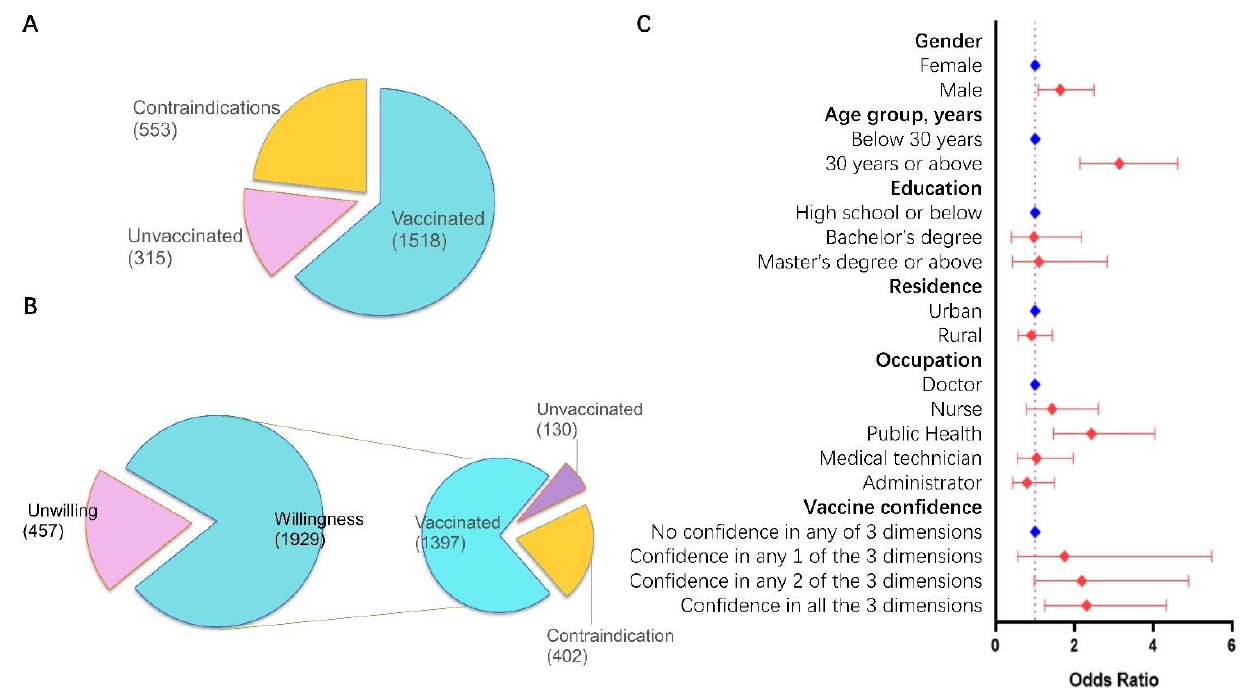
Figure 1. Prevalence and multi-factor analysis on vaccination willingness and coverage of the survey. Note: ( A ). The composition of the current vaccination status of the total population. ( B ). The proportion of vaccination uptake among those reporting willingness to vaccination. ( C ). Logistic regression analysis on vaccination uptake rate among those reporting willingness to vaccination. The reference groups were set as female, aged below 30 years, high school or below, urban